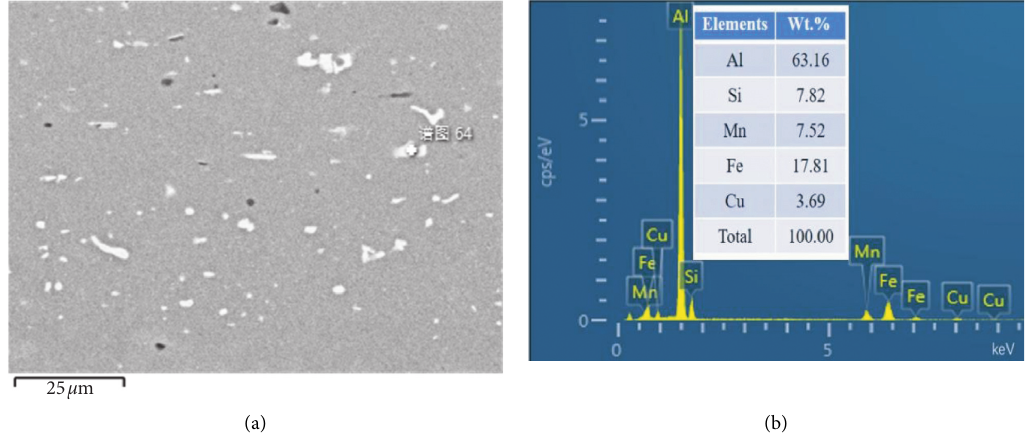
Figure 19: Typical SEM images of the brazed specimen rolled to 30% and annealed at 360 °